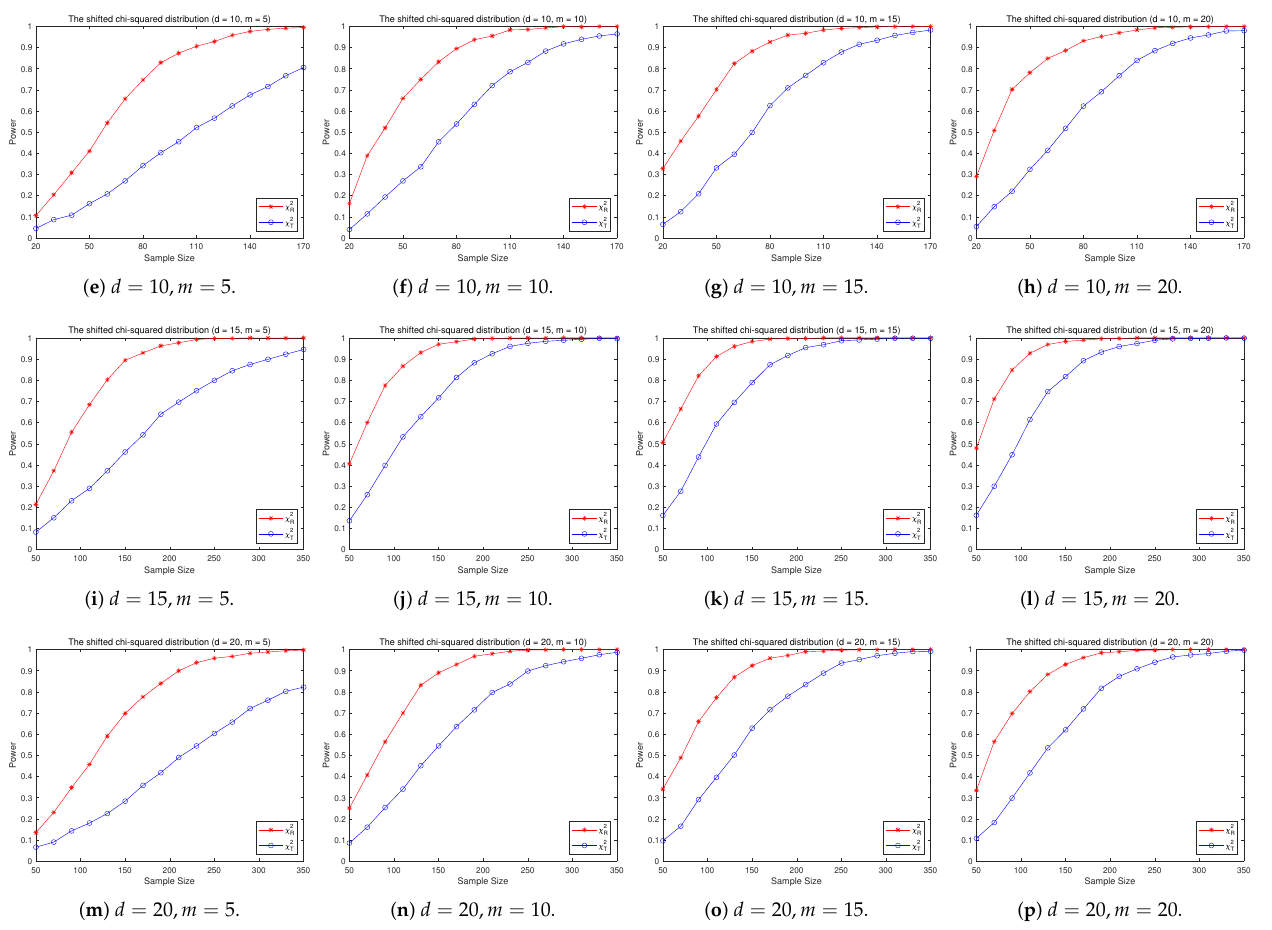
Figure 4. The shifted chi-square distribution with degree of freedom 1. Red line for RP-chi-square, blue line for traditional chi-square.